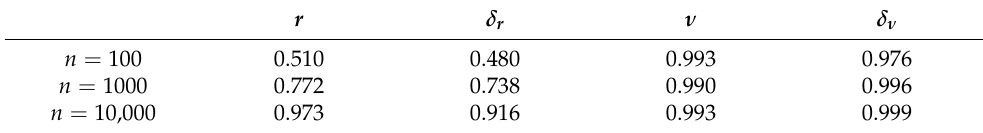
Table 6. Proportions of true parameter values falling into asymptotic confidence intervals for 1000 runs for the sample size n with true parameter values r = 0.5, ν = 0.7, s = 1.5, t = 0.6, δ =